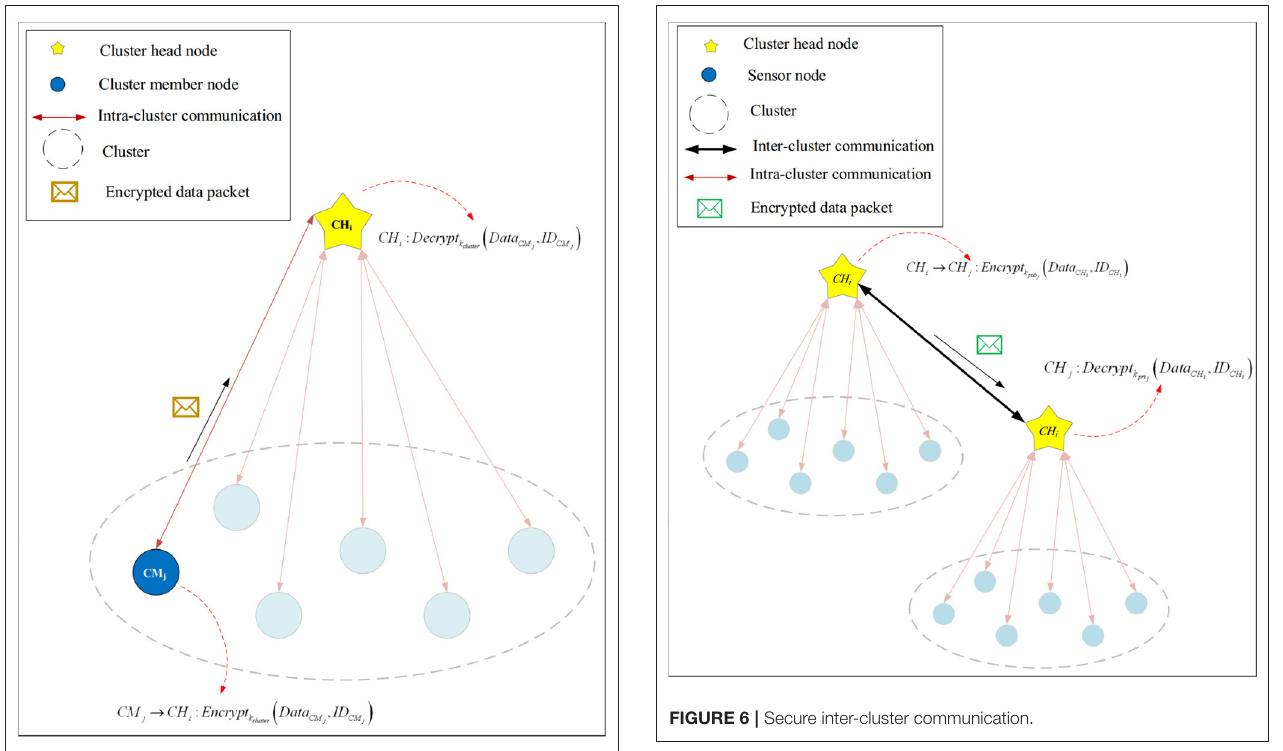
FIGURE 5 | Secure intra-cluster communication.